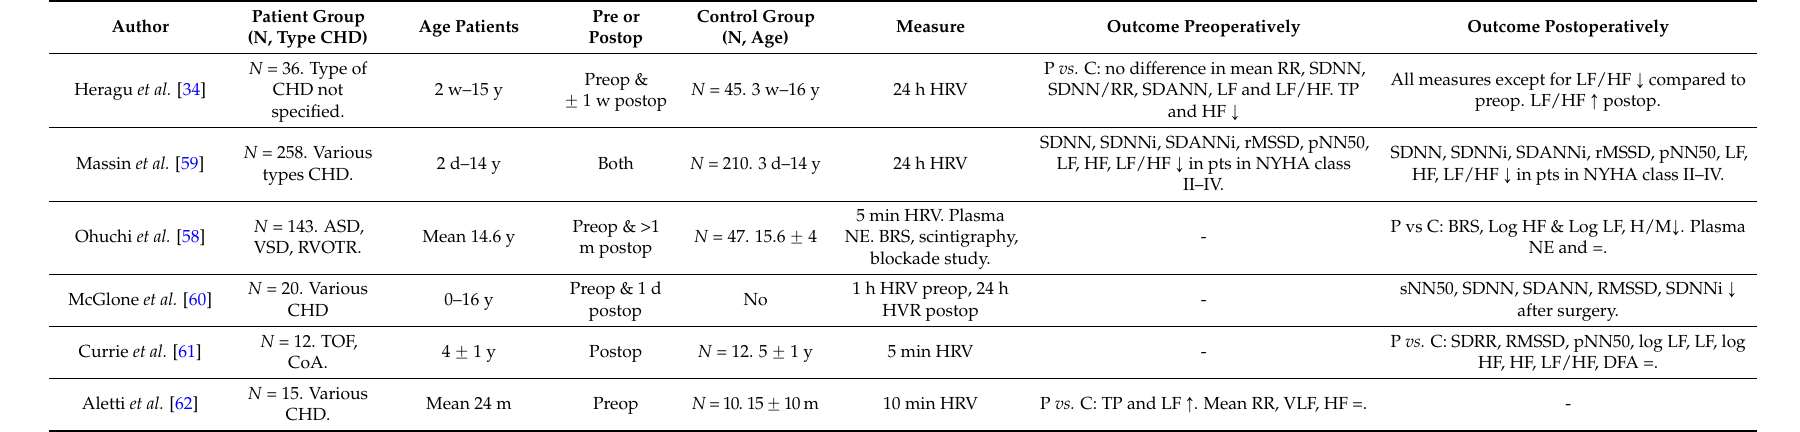
Table 3. Overview of studies grouped by type of